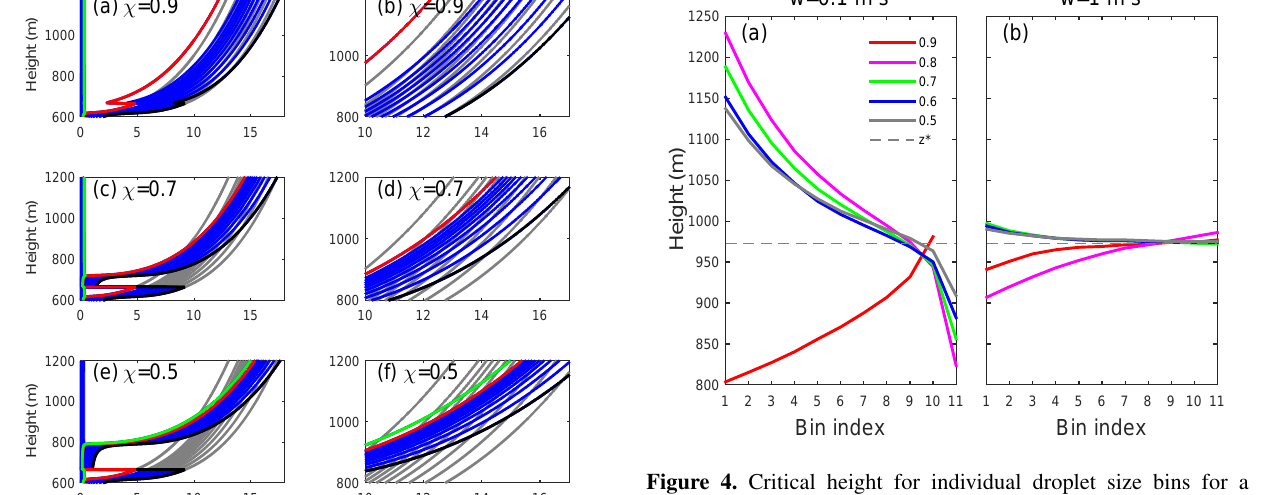
Figure 4. Critical height for individual droplet size bins for a polydisperse cloud droplet population calculated from cloud par- cel model. Results are shown for two updraft velocities, (a) w = 0 . 1ms − 1 and (b) w = 1 . 0m s − 1 . The line colors represent differ- ent mixing fractions χ as defined in the legend, and the dashed line is the analytical result for critical height z ∗ for a monodisperse cloud droplet population. Cloud droplet size decreases as the bin number